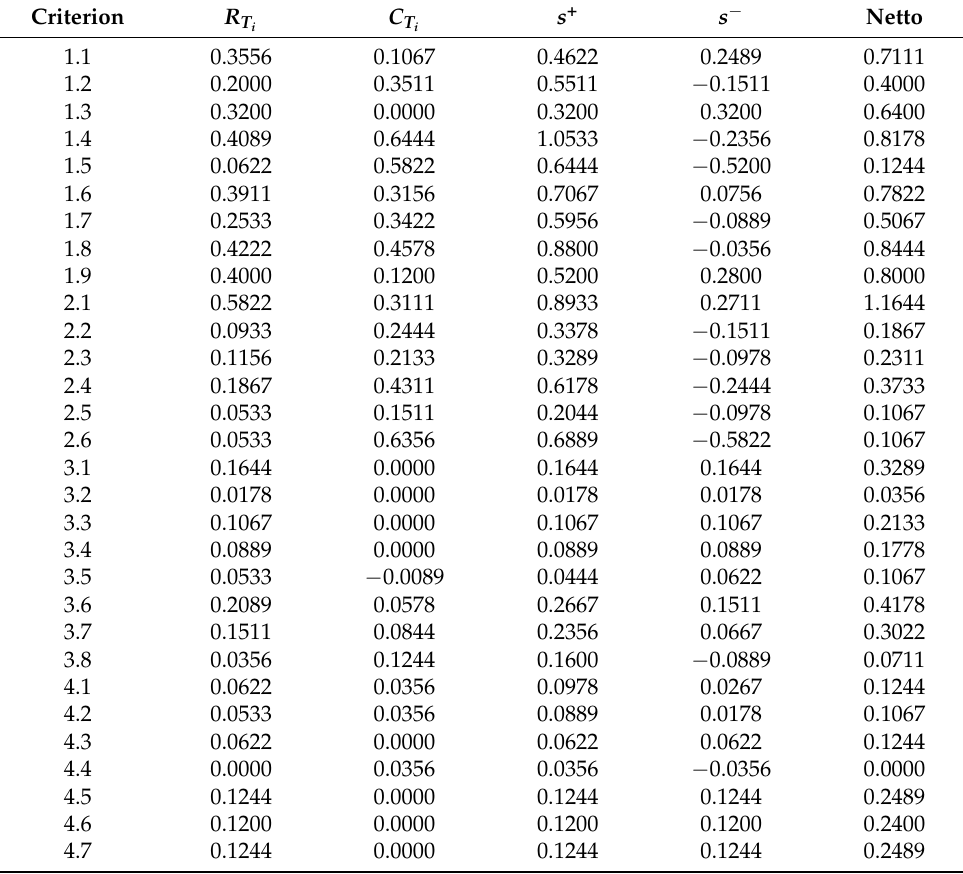
Table 2. Summary of DEMATEL analysis